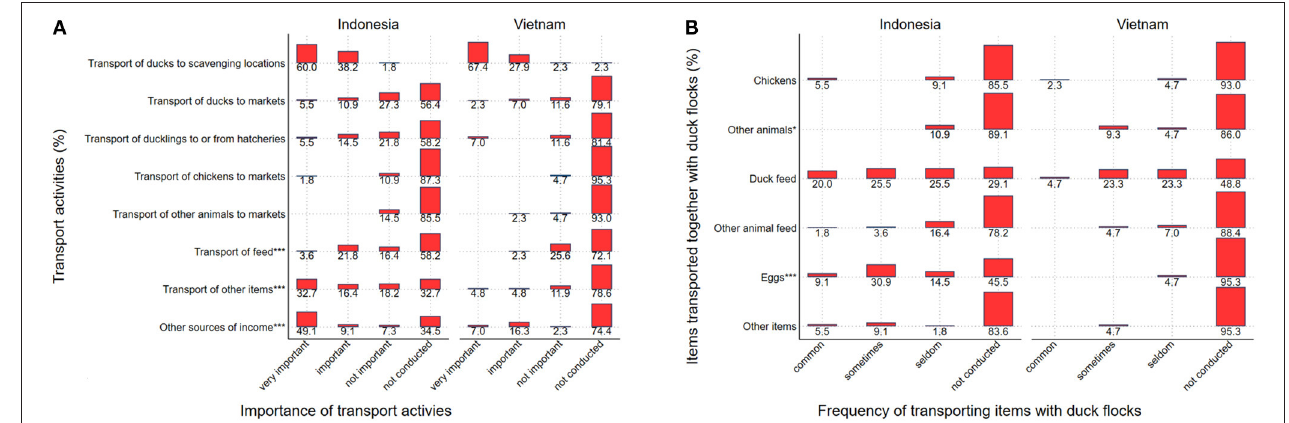
FIGURE 1 | (A) Importance of transport activities for transporters of moving duck flocks in Indonesia ( N = 55) and Vietnam ( N = 43), with percent of respondents by importance category. (B) Items transported together with ducks to scavenging locations for Indonesia ( N = 55) and Vietnam ( N = 43), with percent of respondents by frequency category. P -values for comparisons between countries for each category are presented as follows: * for P ≤ 0.05, *** for P ≤ 0.001.